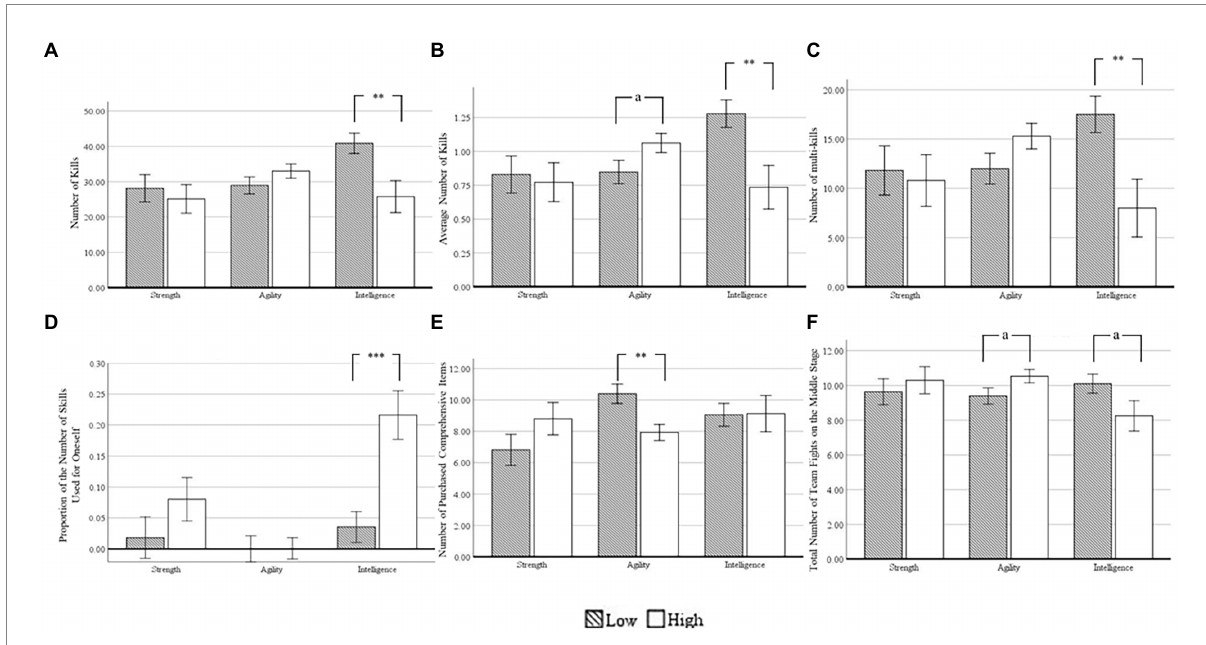
FIGURE 1 Differences between low- and high-level self-regulation group of different hero types on (A) number of kills, (B) average number of kills, (C) number of multi-kills, (D) proportion of the number of skills used for oneself, (E) number of purchased comprehensive items, and (F) total number of team fights on the middle stage. Low: the low-level self-regulation group; High: the high-level self-regulation group. The error bar represents standard error. a p < 0.10; * p < 0.05; ** p < 0.01; *** p <